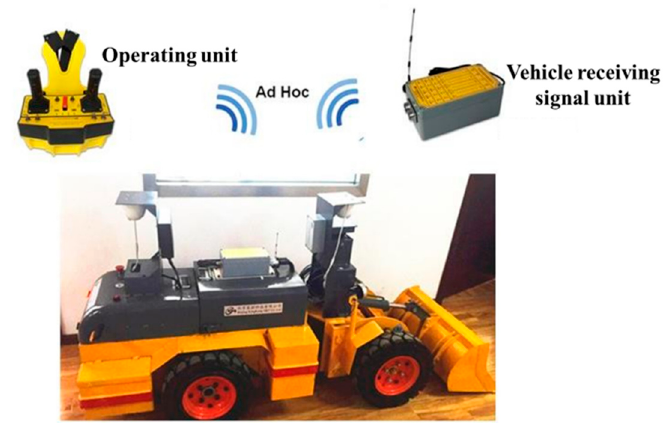
Figure 9. Underground mine trackless equipment experimental platform.